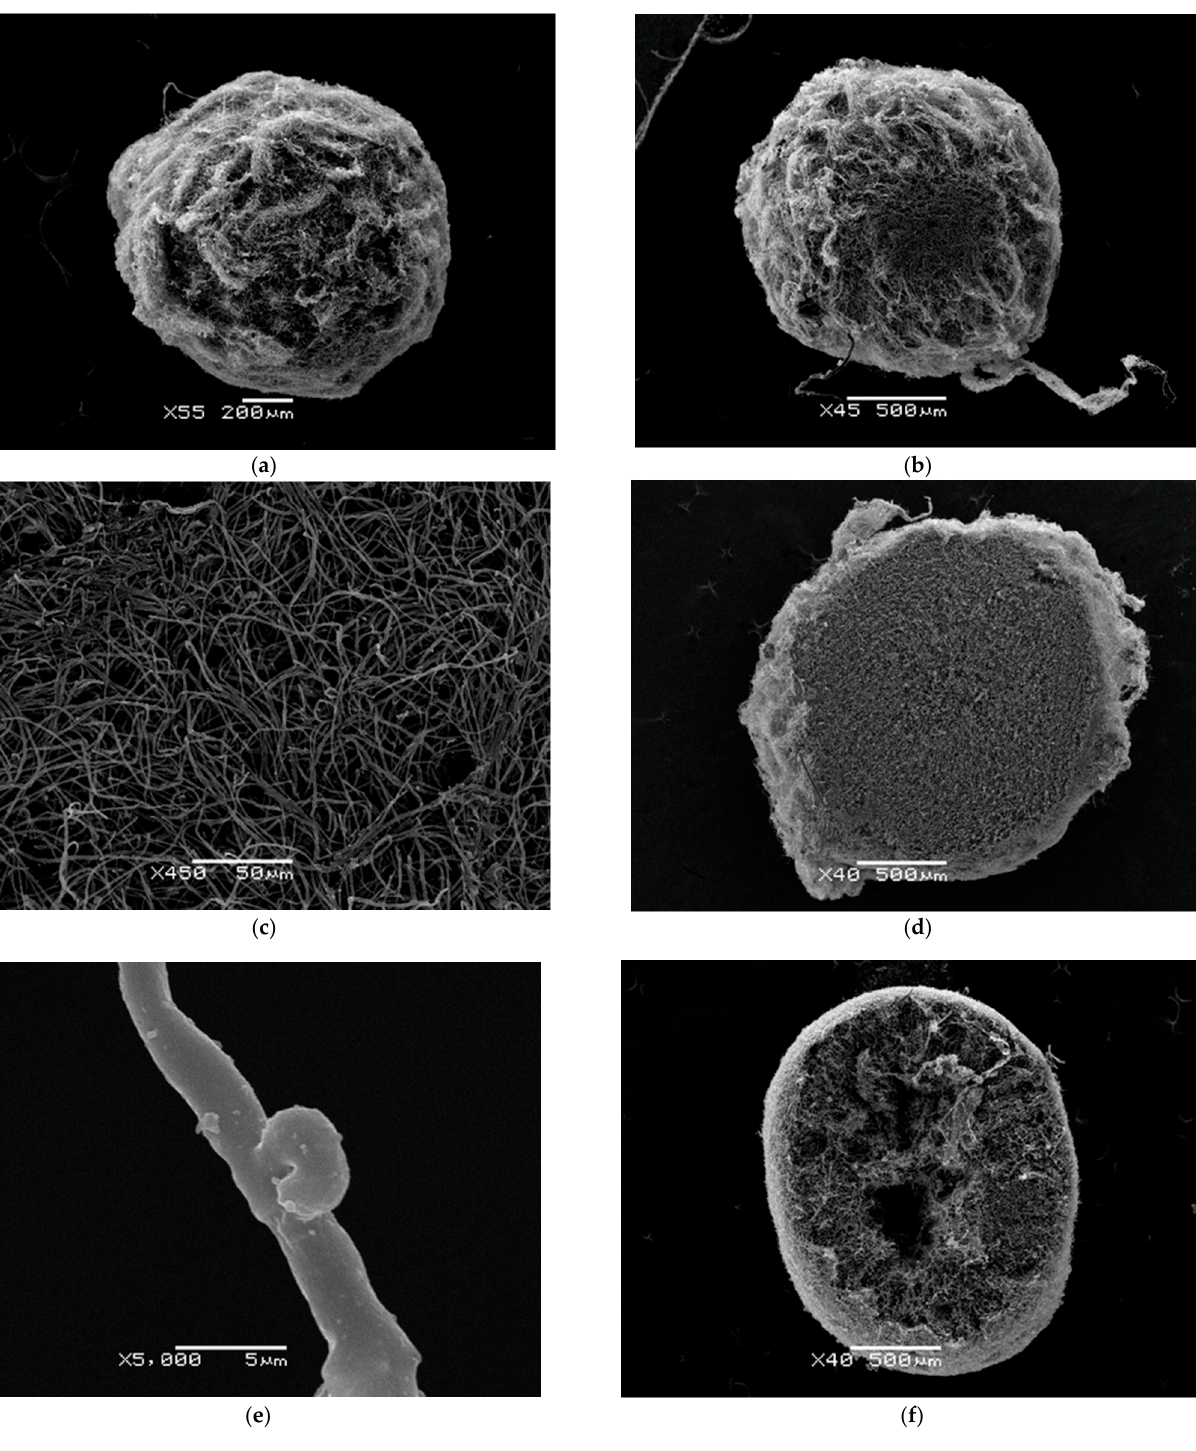
Figure 6. Scanning electron microscopy of F. velutipes submerged mycelium: ( a , b )—general view of the pellets, ( c )—pellet surface, ( d )—pellet slice, ( e )—hyphae with clamp connection, ( f )—slice of G. frondosa pellet.